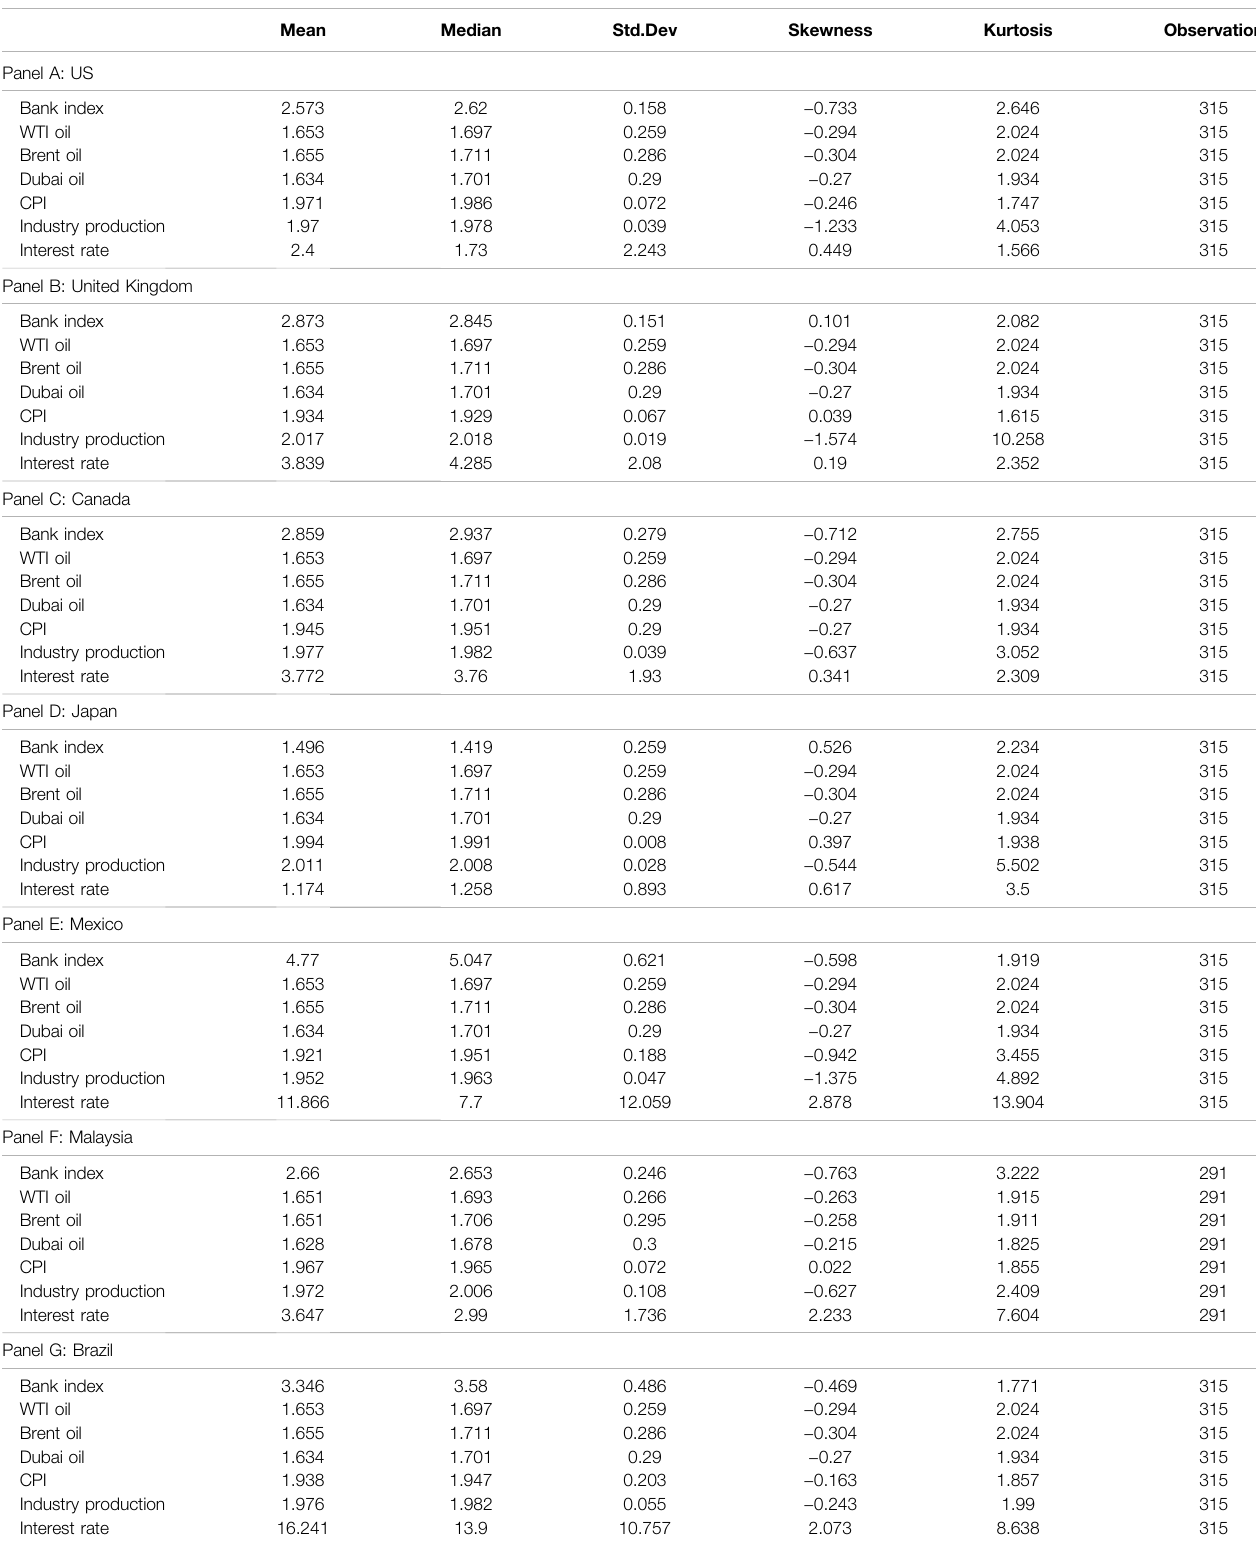
TABLE 2 | Descriptive statistics. Mean Median Std.Dev Skewness Kurtosis